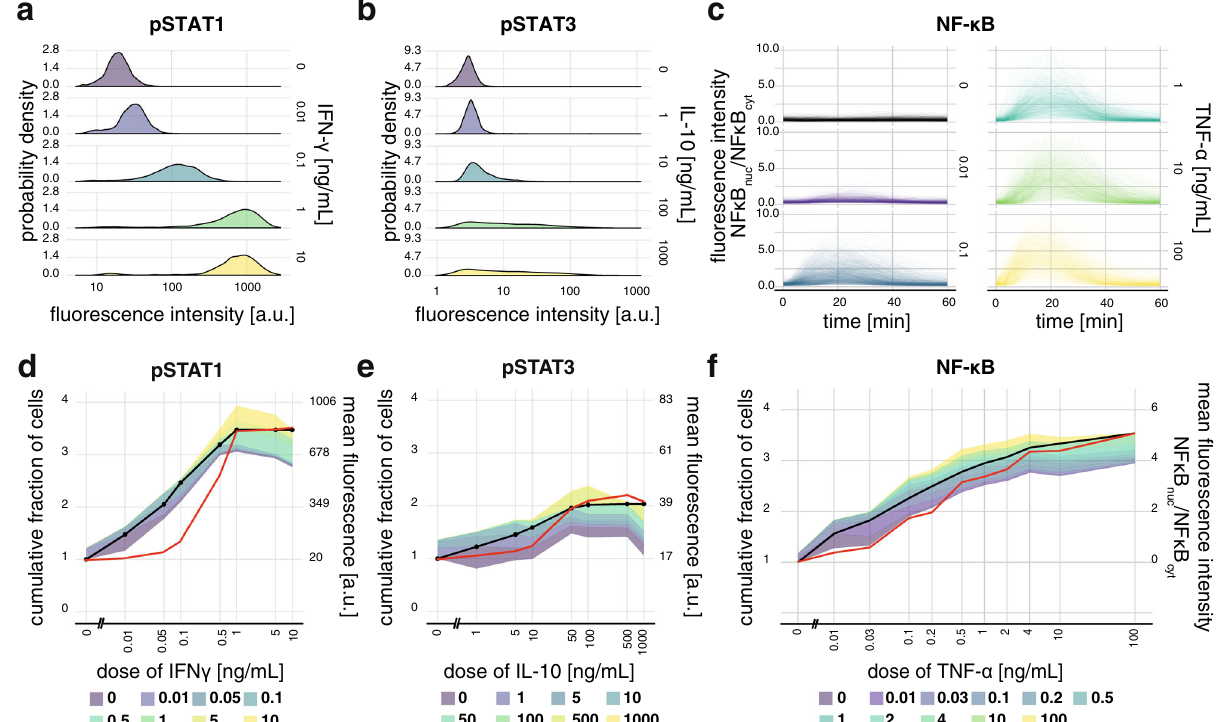
Fig. 4 IFN- γ , IL-10, and TNF- α exhibit logarithmic dose – responses in cell lines. a Distributions of responses 30 min after stimulation with different doses of IFN- γ in terms of nuclear pSTAT1 as measured with confocal microscopy imaging and immunostaining in the U937 cell line. Responses are expressed as mean fl uorescence of nuclear pixels. Selected doses are shown. See Supplementary Fig. 9 for all doses. b The same as in a but for pSTAT3 after stimulation with IL-10. c Temporally resolved responses of individual murine embryonic fi broblasts to increasing concentrations of TNF- α . Each line corresponds to a single cell. Responses are expressed as the ratio of the nuclear pixels fl uorescence average to the cytoplasmic-pixels fl uorescence average. Selected doses are shown in the panel. See Supplementary Fig. 10 for all doses. Measurements were taken every 3 min in a murine embryonic fi broblast cell line stably expressing the p65 protein component of the NF- κ B complex fused with the fl uorescent dsRed protein. d FRA of IFN- γ responses. For comparison, the red line presents the mean response with y- axis on the right. The pie-chart corresponding to the plotted cell-to-cell heterogeneity structure is shown in Supplementary Fig. 11. Comparison with mean of log-data is shown in Supplementary Fig. 12. e Same as in d but for IL-10 responses. f FRA of the temporally resolved responses to TNF- α . The red line presents the mean response at the time of maximal response, i.e., at 18 min. Comparison with mean of log-data at 18 min is shown in Supplementary Fig. 12. Technical details: at least 892 cells were measured per condition. Experiments were performed in two biological repeats each consisting of two technical replicates. In a and b , the sum of two technical replicates of a representative biological replicate is shown. In c sum of biological replicates is shown 26